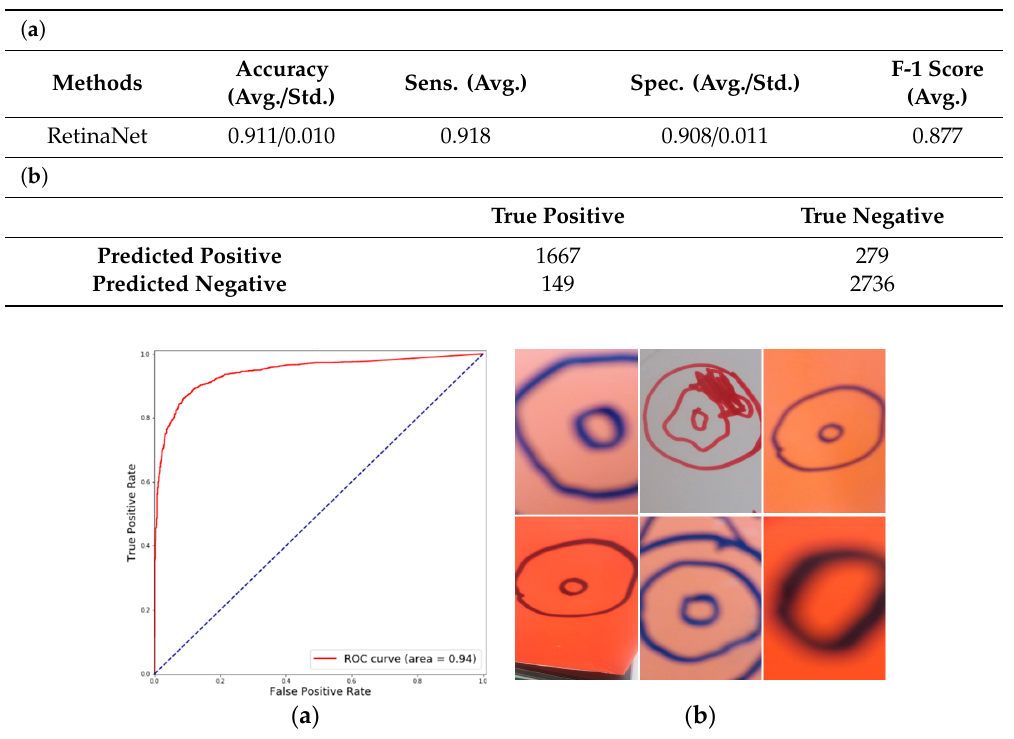
Table 3. Performance measurement ( a ) and the confusion matrix of one test fold ( b ) for RetinaNet approach on test images. Positive: non-cervix image. (Sens. = Sensitivity, Spec. = Specificity, Std. = Standard deviation, Avg. = Average).